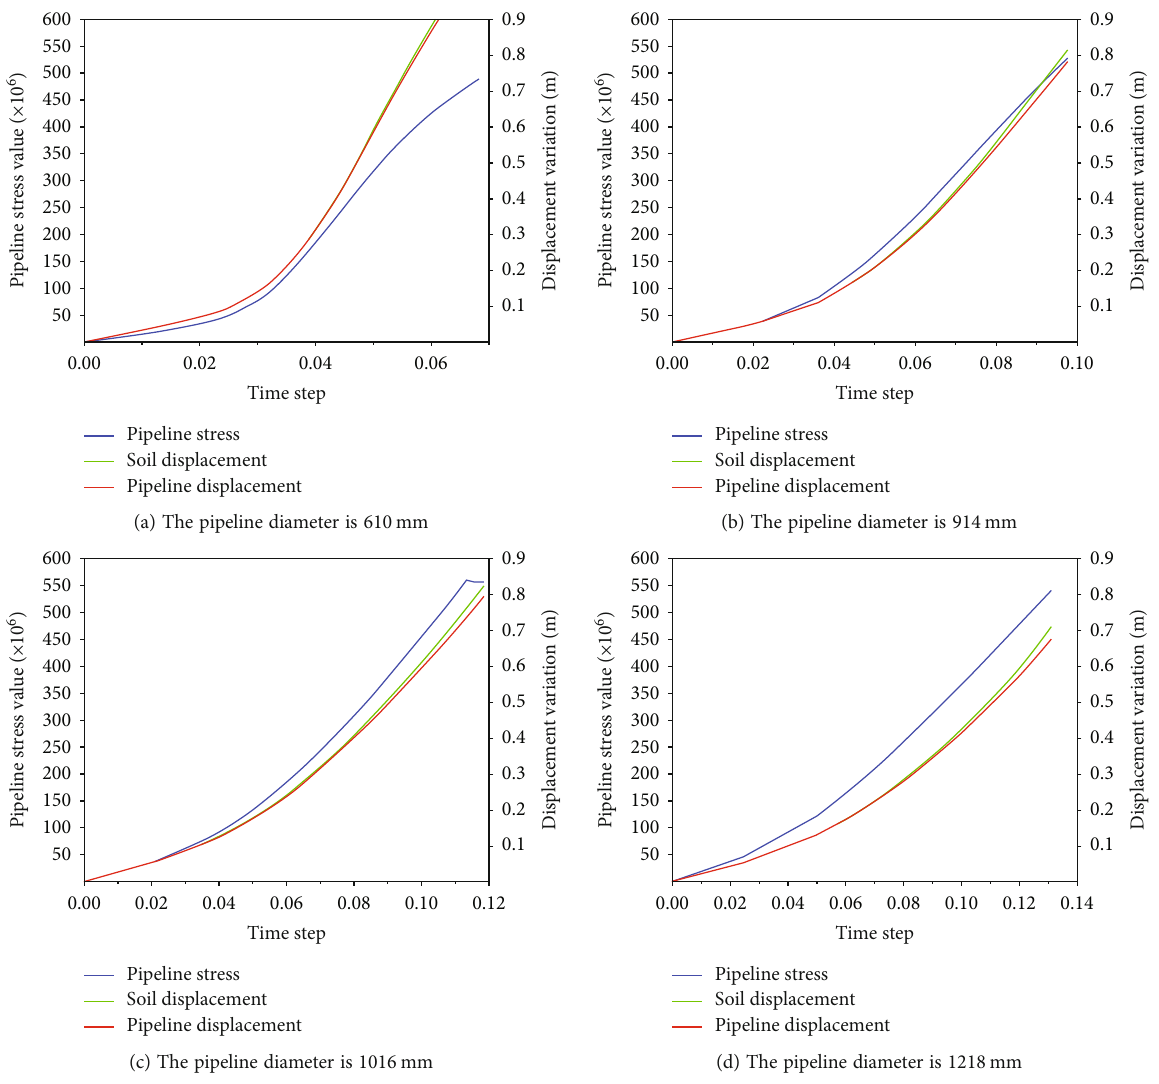
Figure 22: The diagrams of pipeline stress, displacement, and soil displacement under di ff erent pipeline